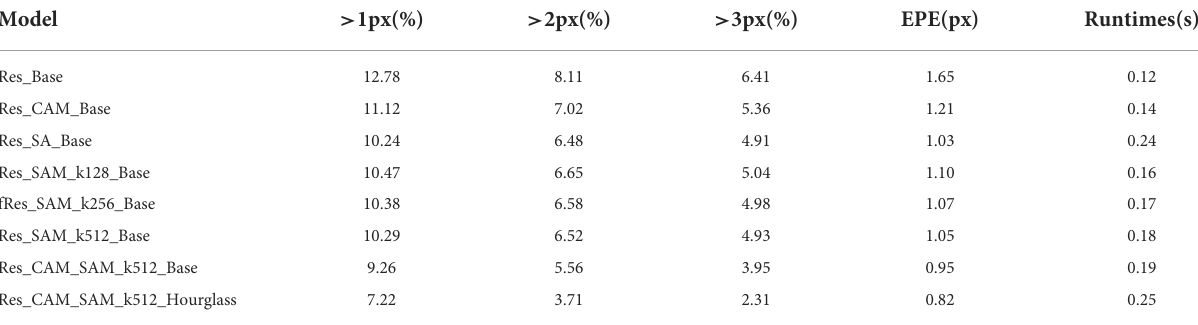
TABLE 4 Ablation experiments on scene